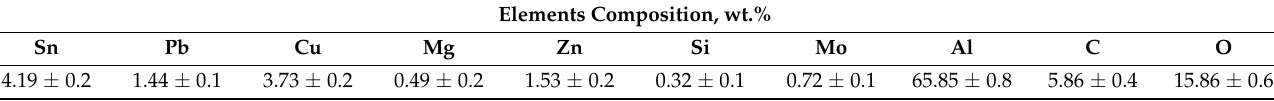
Table 4. Chemical composition of sintered Al–Mo